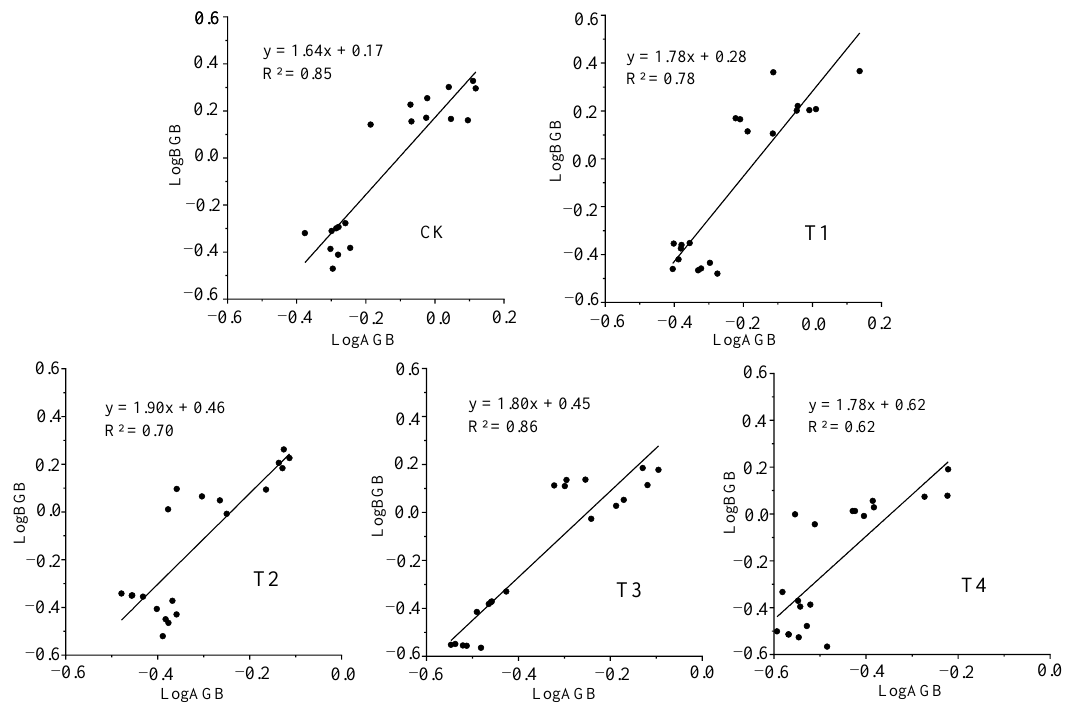
Figure 1. The biomass distribution in organs of Glycyrrhiza uralensis under different water stress treatments. Different lowercase letters indicate significant differences among treatments at 5% level.